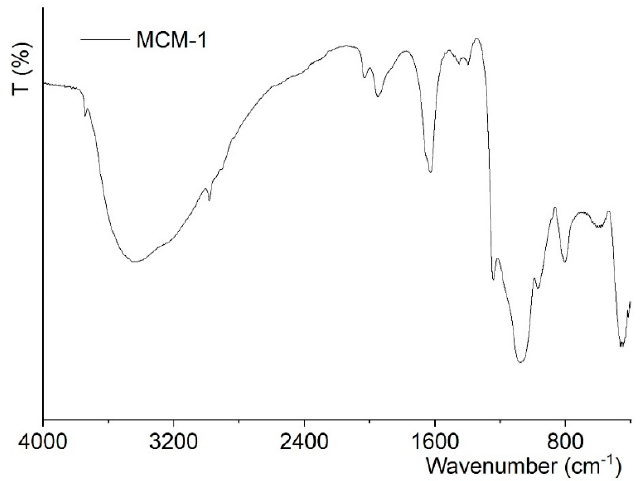
Figure 5. Infrared spectrum of the material MCM-1.